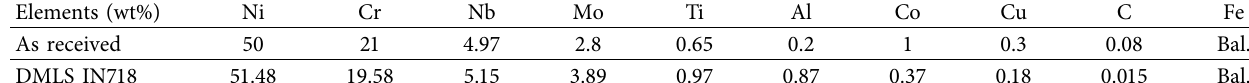
Table 2: Nominal composition of Inconel